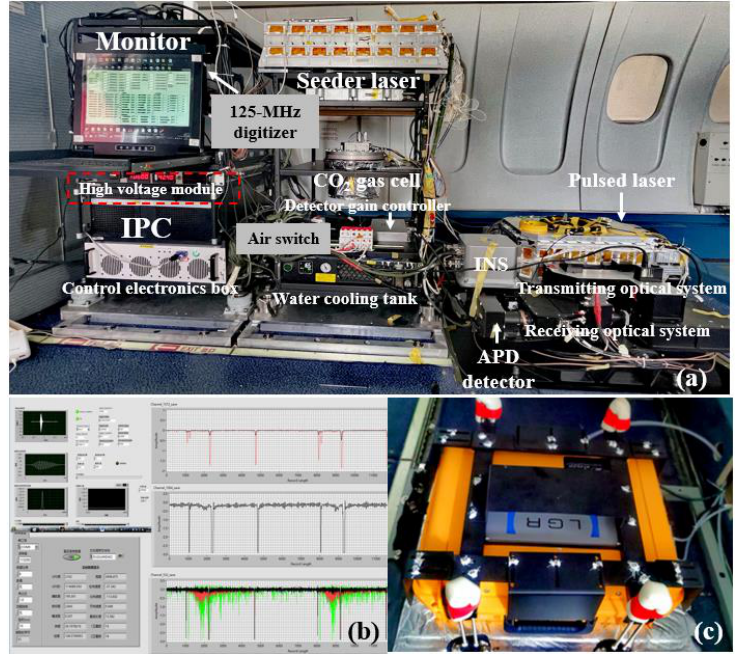
Figure 1. Pictures of the aircraft Instrumentation. ( a ) The ACDL system. ( b ) The control interfaces of some instruments. ( c ) The Ultraportable Greenhouse Gas Analyzer (UGGA).